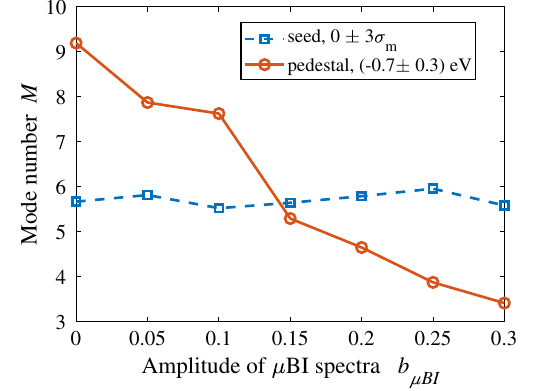
FIG. 8. The effective number of modes M as a function of the integration bandwidth under the conditions: constant seed with μ BI, fluctuating seed without μ BI, fluctuating seed with μ BI. The dotted line is the effective number of modes of the spectral sidebands calculated by Eq. (16).